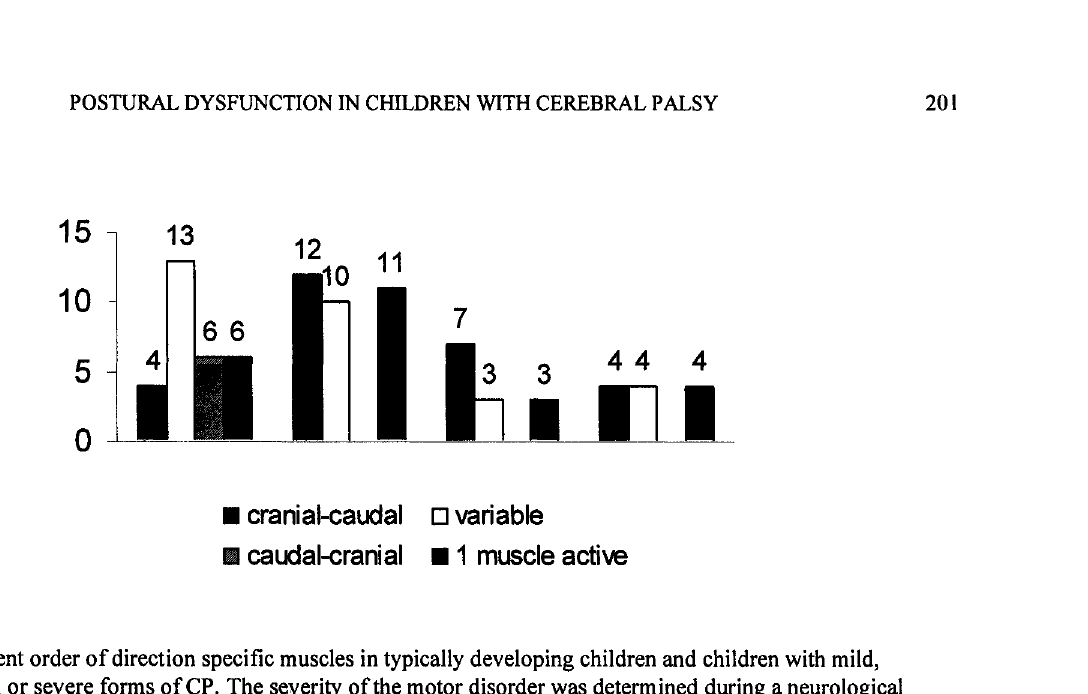
Fig. 1: Recruitment order of direction specific muscles in typically developing children and children with mild, moderate, or severe forms of CP. The severity ofthe motor disorder was determined during a neurological examination. Prevailing recruitment order was determined based on the mean latencies after prime mover onset per child. Crania-caudal recruitment: trunk muscle recruited > 100 ms later than neck muscle, caudal-cranial recruitment: neck muscle recruited > 100 ms later than trunk muscle, variable recruitment order: neck and trunk muscles recruited with a mean delay of < 100 ms. muscle active: either neck extensor or trunk extensor was activated in isolation precluding the calculation of a recruitment